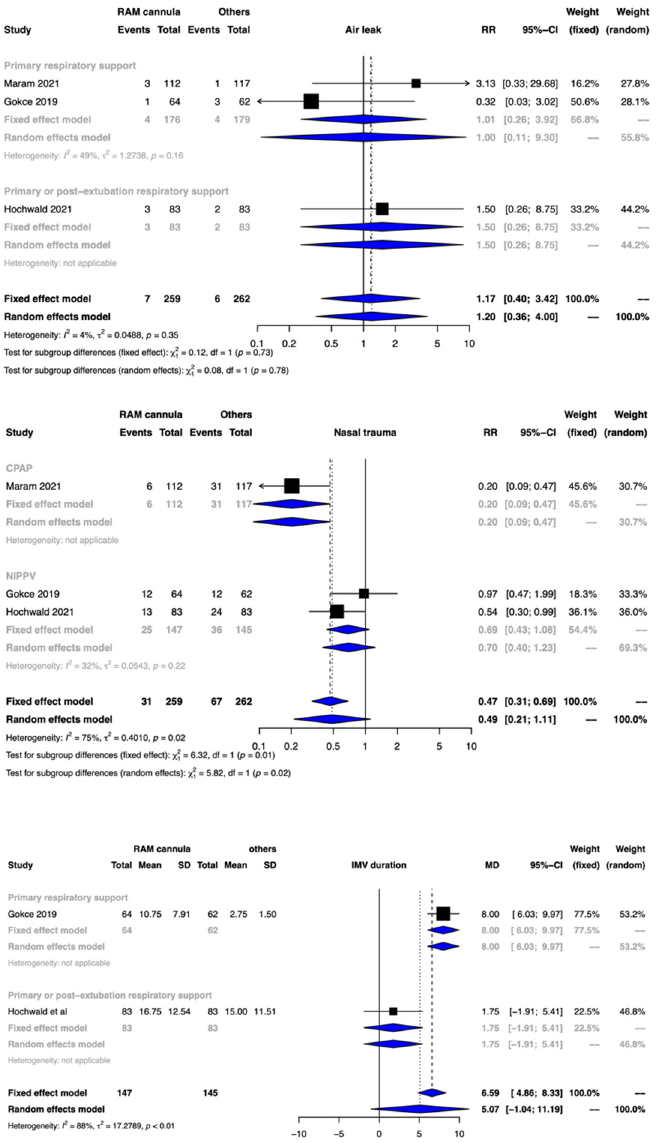
Figure 3. Forest plots depicting the effect estimates for the outcomes: air leak, nasal trauma, and invasive mechanical (IMV) duration.